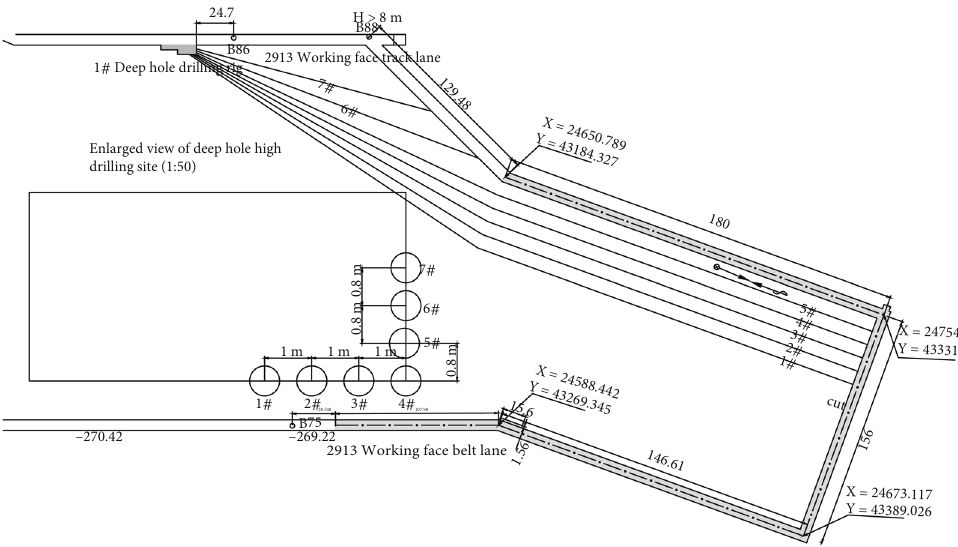
Figure 8: 2913 working face high drilling layout.